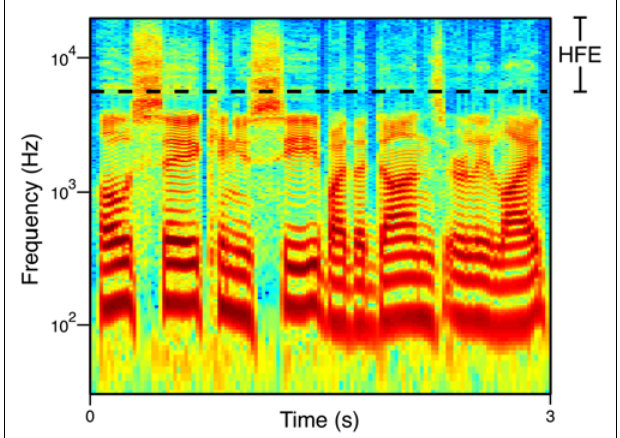
FIGURE 1 | Broadband spectrogram of speech. The phrase shown is “Oh say can you see by the dawn’s early light” spoken by a male talker.The HFE range (the 8- and 16-kHz octaves) is